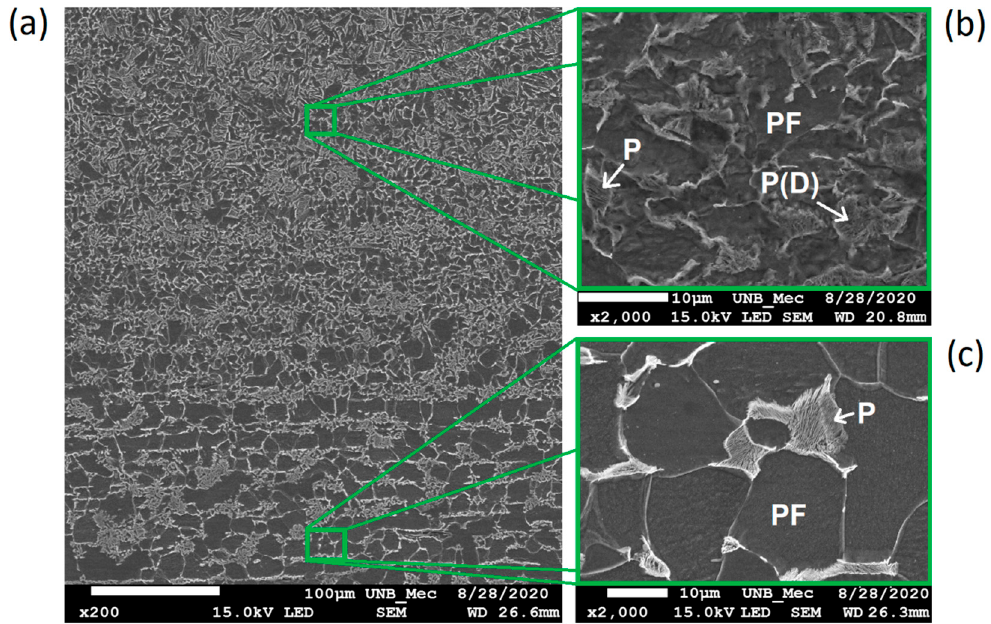
Figure 8. SEM images of ( a ) boundary FGHAZ/IHAZ (with 200× ampliation), ( b ) FGHAZ, and ( c ) IHAZ (2000× ampliation both). Etching: Nital 5%.